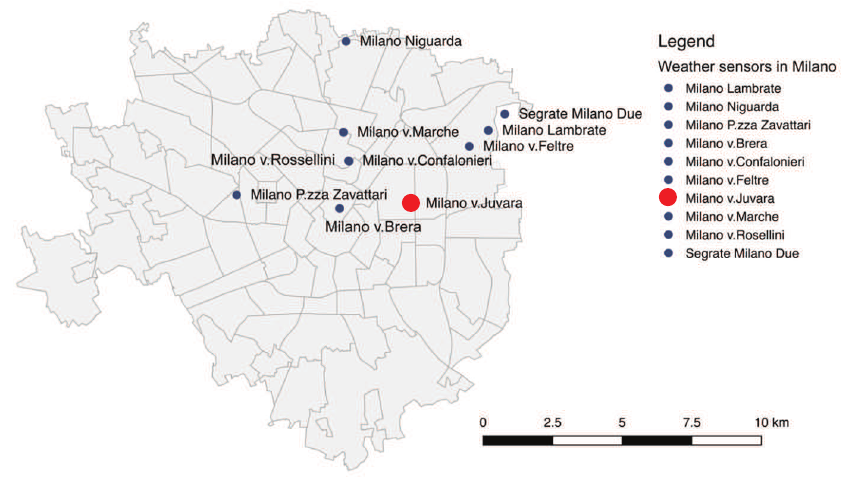
Figure 1. Location of the Milano via Juvara station within the city of Milan divided by NILs.